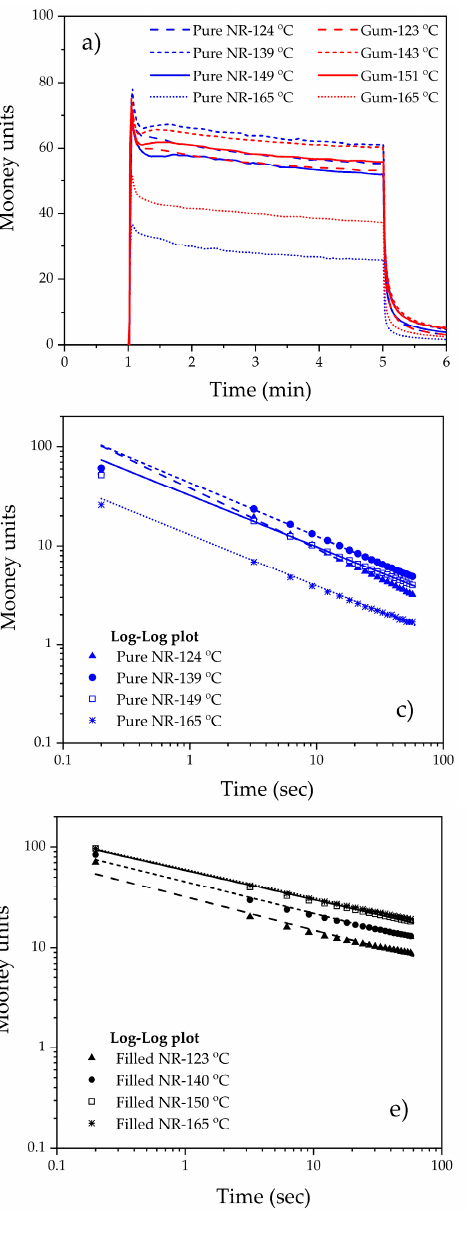
Figure 1. Mooney curves ( a , b ) and double logarithmic plots of Mooney stress relaxation ( c – e ) of masticated pure NR, unfilled, and filled NR compounds subjected to various dump temperatures.